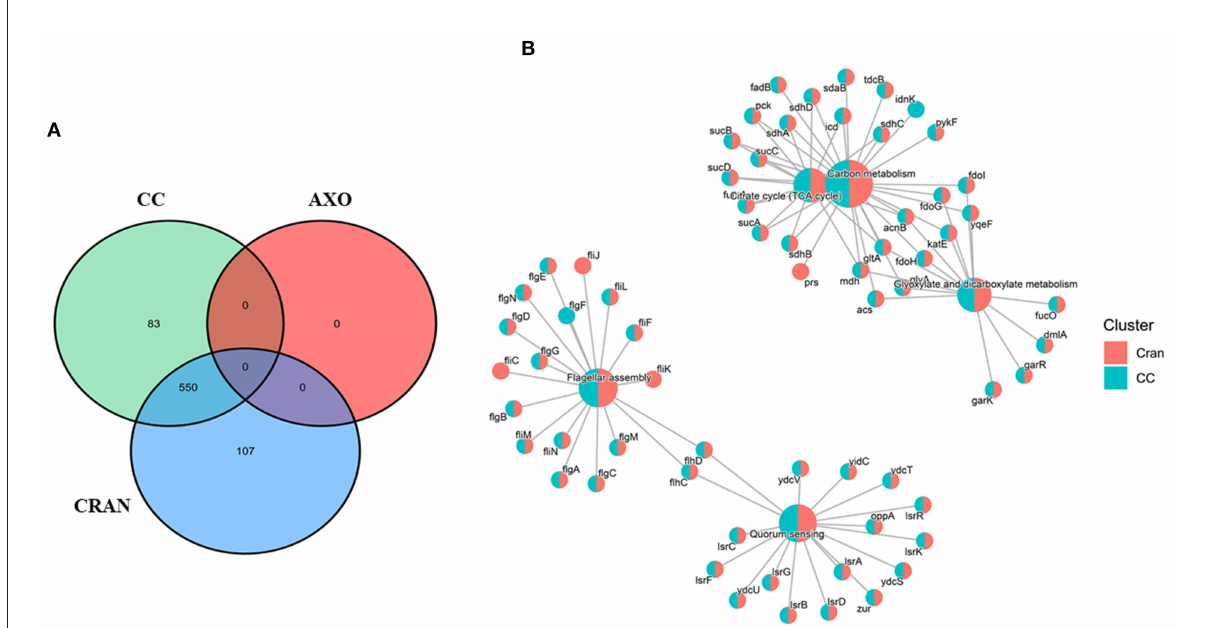
FIGURE3 (A) Venn diagram showing overlap of differentially expressed genes following exposure to 4 mg/mL of cranberry pomace extracts (CRAN), 4 µ g/mL of AXO, and (4 µ g/mL AXO + 4 mg/mL CRAN) CC for 3h. (B) Gene set enrichment analysis (GSEA) grouped by KEGG pathway showing the clustering of a similar set of differential gene expressions due to CRAN and CC exposures compared to control. A log 2 -fold change of > 2 and false discovery rate (FDR) cutoffs ≤ 0.001 are